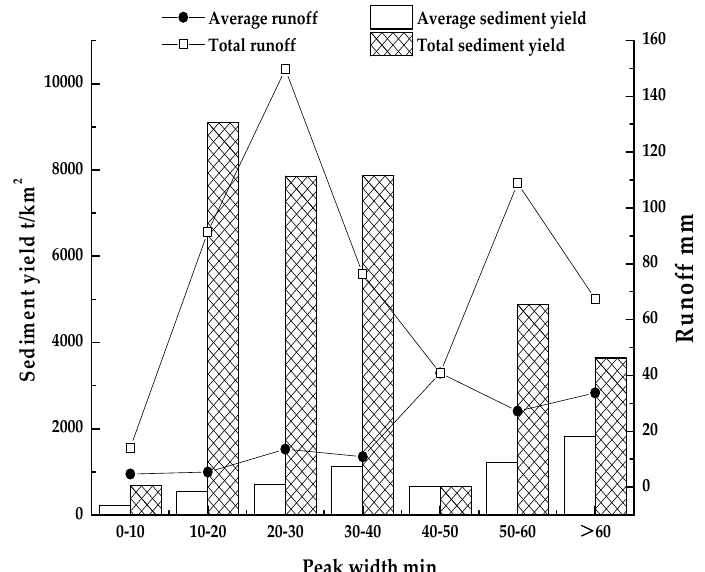
Figure 4. Runo ff and sediment yield characteristics of rainfalls with di ff erent peak Figure 4. Runoff and sediment yield characteristics of rainfalls with different peak widths.